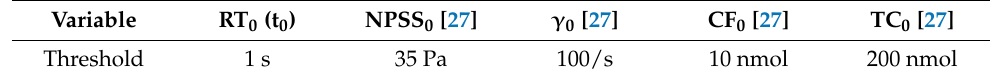
Table 1. The thresholds of the reaction variable.